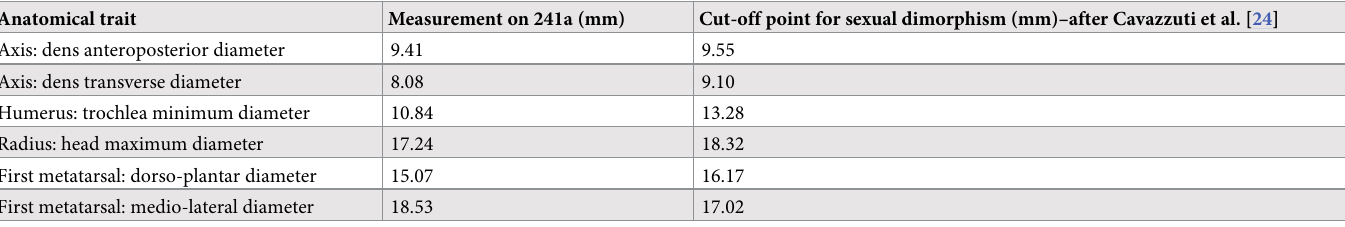
Table 4. Comparison between the measurements taken on the sexual dimorphic anatomical traits of the burial n. 241a compared with the cut-off points between female and male metric distributions for each trait published by Cavazzuti et al. [24]. Only the medio-lateral diameter of the first metatarsal is more robust than the cut-off point. All the other traits are more compatible with metric distributions for females. Anatomical